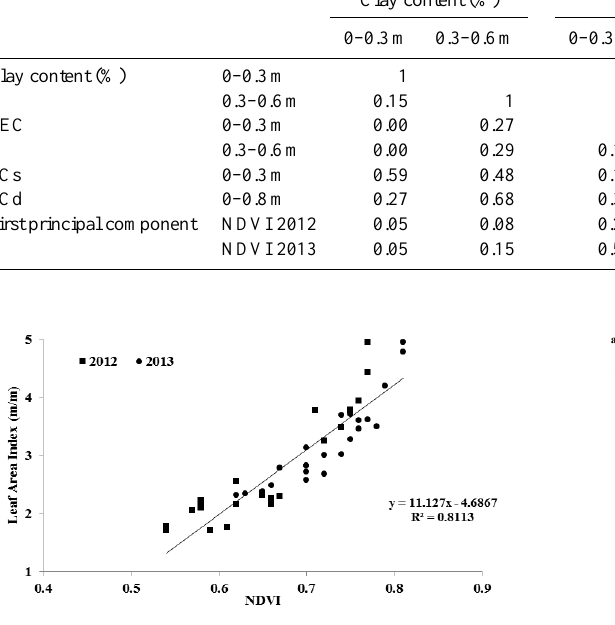
Figure 5. NDVI–LAI relationship of both 2012 and 2013 years.